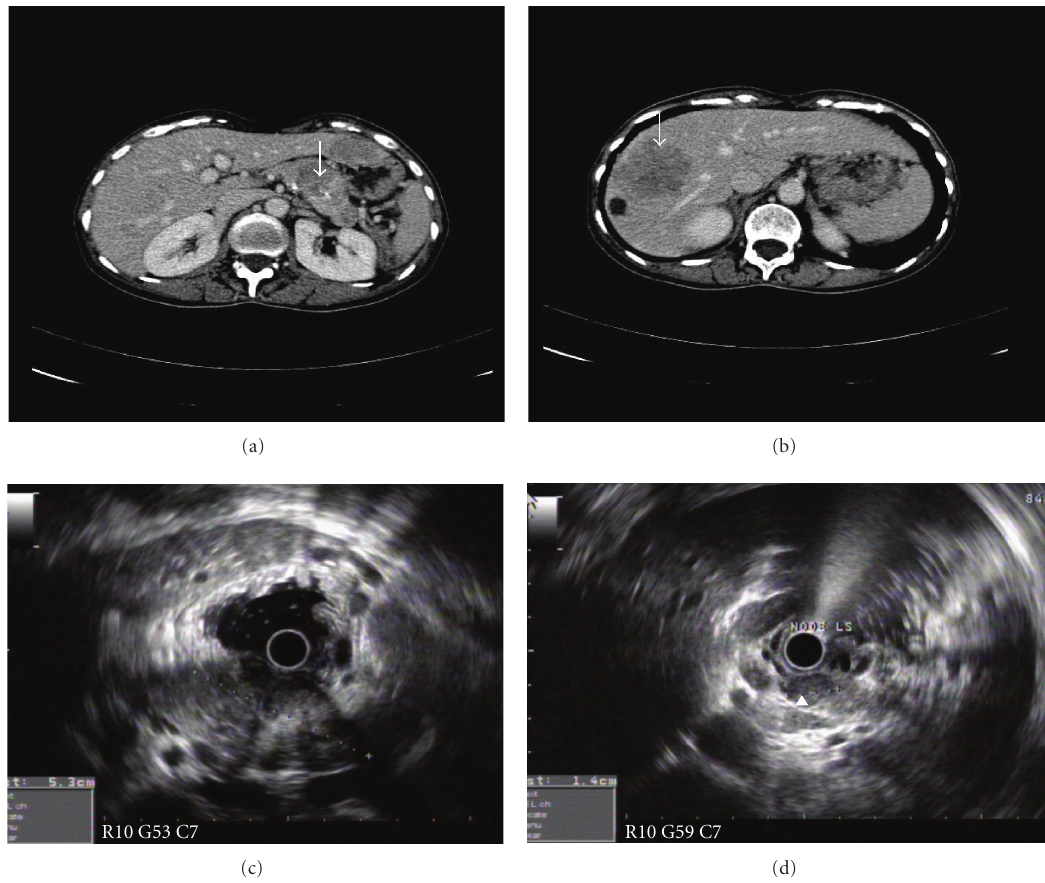
Figure 1: MD-CT scan demonstrating a hypodense lesion (arrow) with spots of peripheral calcifications in the body/tail of pancreas as wells as a large hypodense liver metastasis in the right lobe of liver, arrow (b). (c, d) show at endoscopic ultrasound the presence of the heterogeneous hypoechoic mass involving the body and tail of pancreas with numerous hypoechoic well defined peri-pancreatic lymph nodes